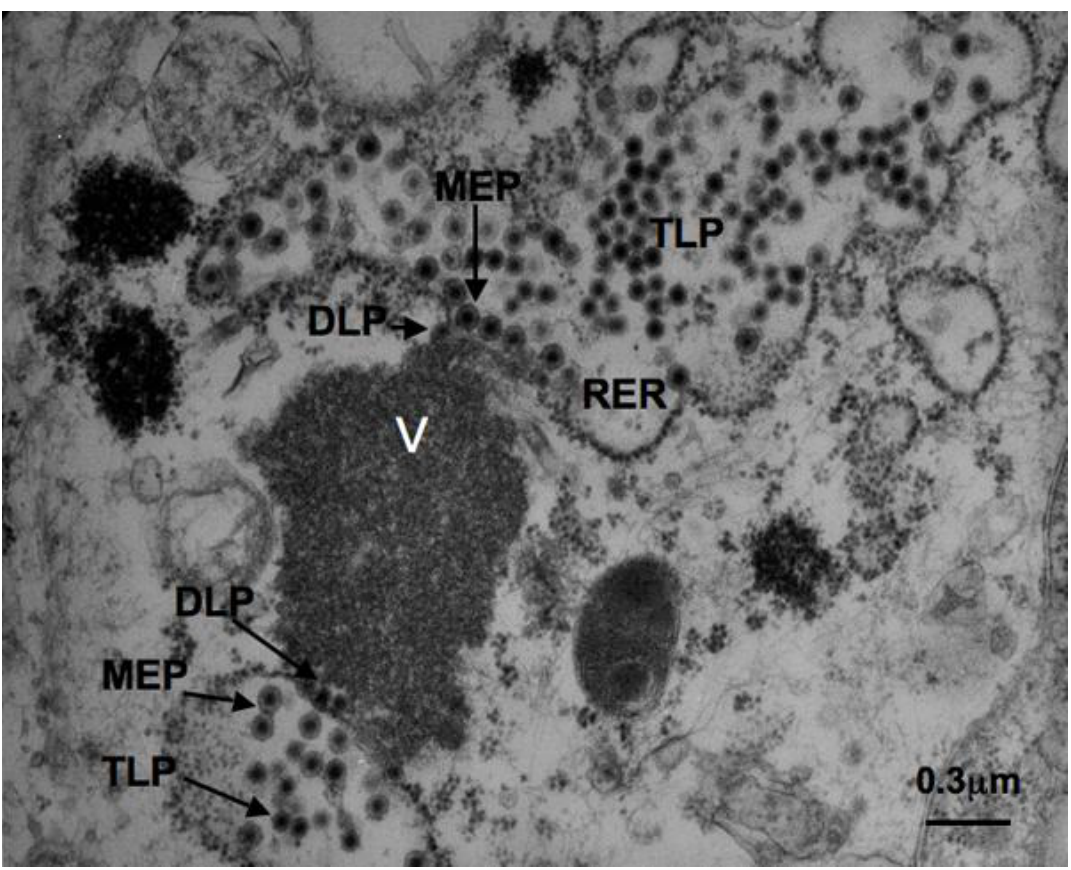
FIGURE 4 . Ultrastructure of rotavirus-infected MA104 cell. DLPs can be observed emerging from the viroplasm (V) and budding into the RER, acquiring ER membrane. These membrane-enveloped particles (MEP) can be seen near the viroplasm or in proximity to the RER membrane. Towards the center of dilated cisternae, TLPs devoid of enveloping membrane can be